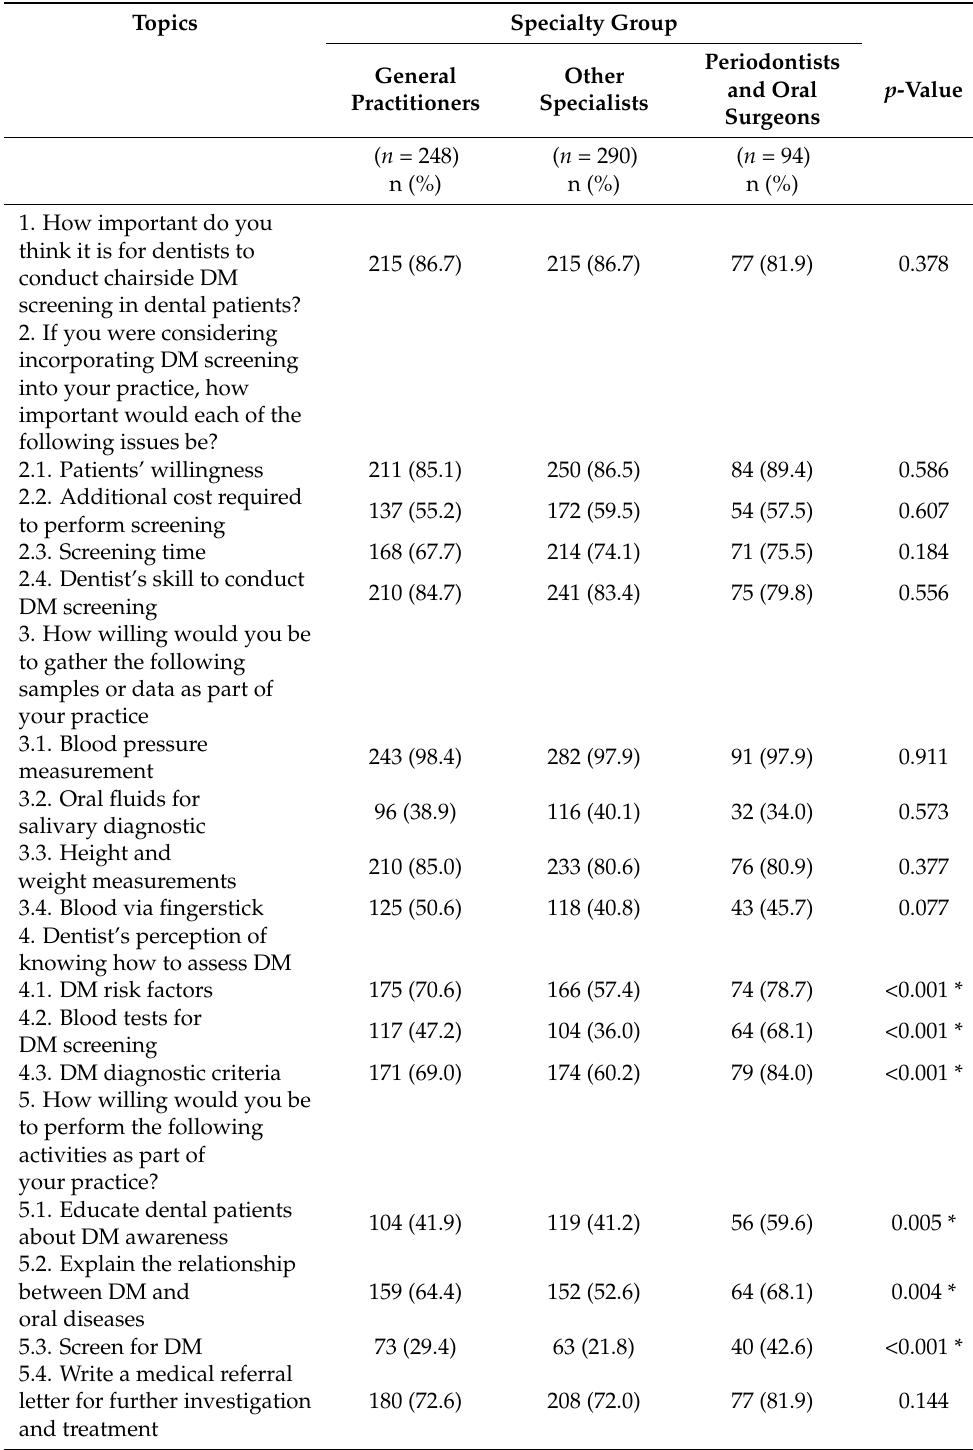
Table 3. Distribution of favorable answers of the attitudes of the dentists toward DM screening in dental clinics based on specialties. Topics Specialty Group Periodontists General Other and Oral Practitioners Specialists